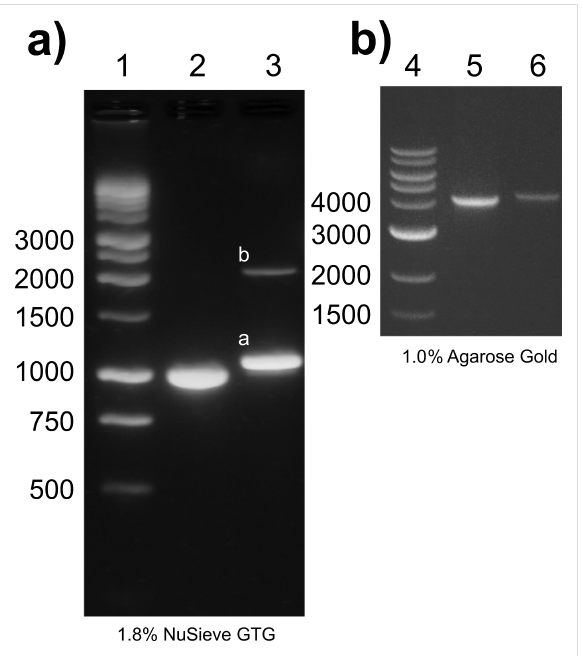
Figure 2: Quantitative analysis of labelled and unlabelled DNA. Gel electrophoresis [(1.8% a) (lane 1, 2 and 3) and 1% b) (Lane 4, 5 and 6)]: DHs of 1000 bp (lanes 2) and 4056 bp (lane 5) respectively, versus PDHs (lanes 3, 6) and a 1 kbp ladder [lane 1 (Promega) and lane 4 (NEB)]. In lane 3 some double-length dsDNA (2000 bp) are visible, linked through streptavidin ( ≈ 5% of the total PDHs) (compare to Figure